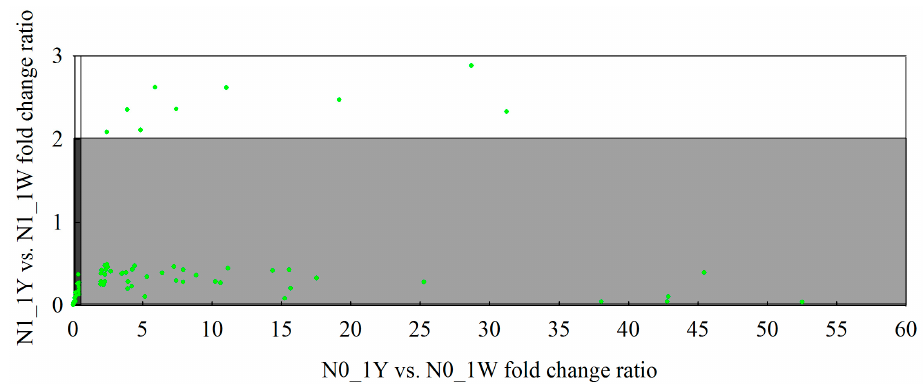
Figure 7. Scatter plot comparing the relative expression ratio for the 72 downregulated genes spe- cifically expressed in the N0_1W vs. N1_1W comparison between wheat NILs under each N treat- ment. Each point represents an individual DEG, and the lighter section of the diagram shows the genes that are potentially relatively upregulated in